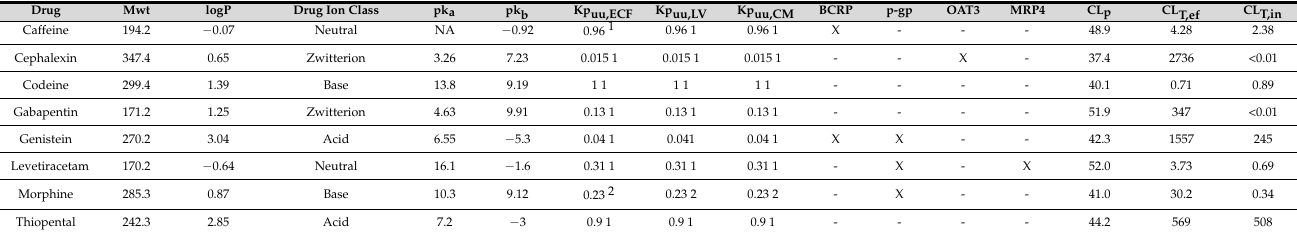
Table 2. Physicochemical properties, active transporters affinities, and BBB transport clearances of selected drugs.